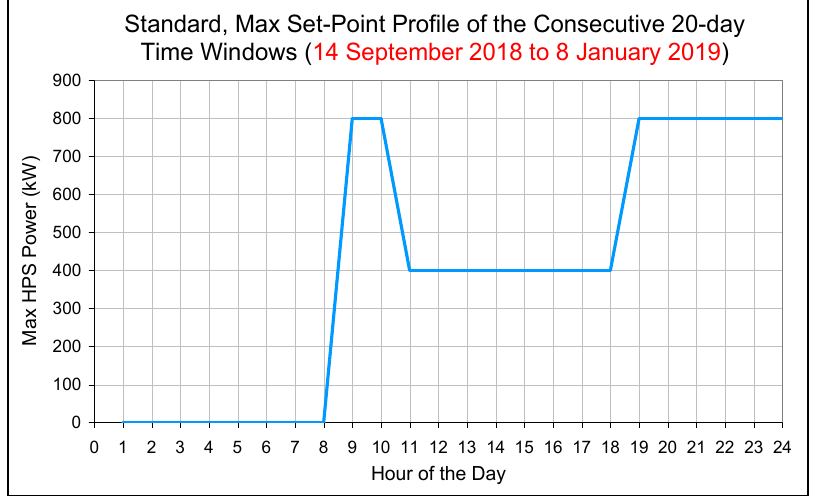
Figure 18. The standard profile of max set-point for the Tilos island HPS.